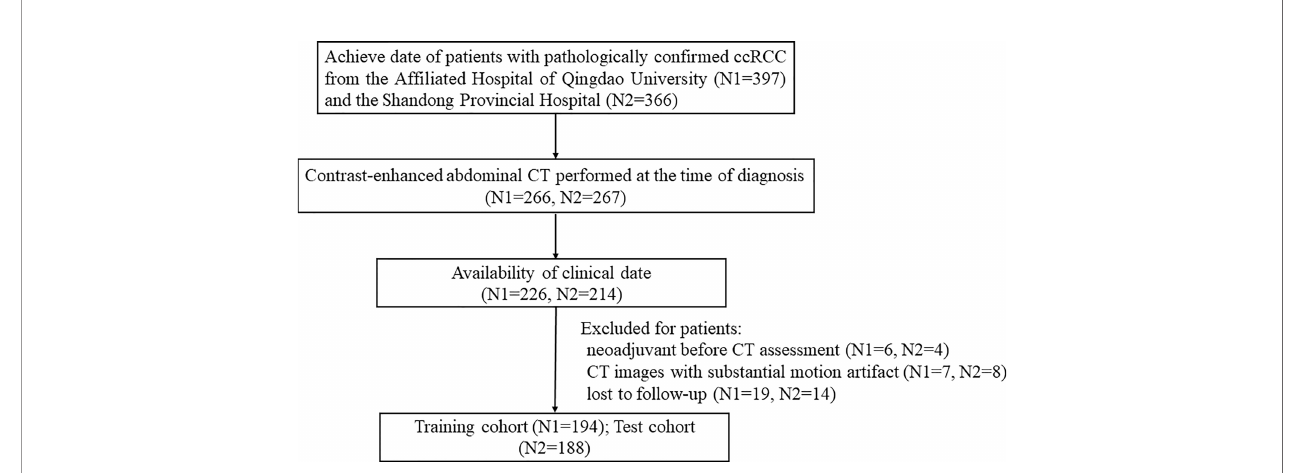
FIGURE 1 | The patient recruitment pathway with inclusion and exclusion